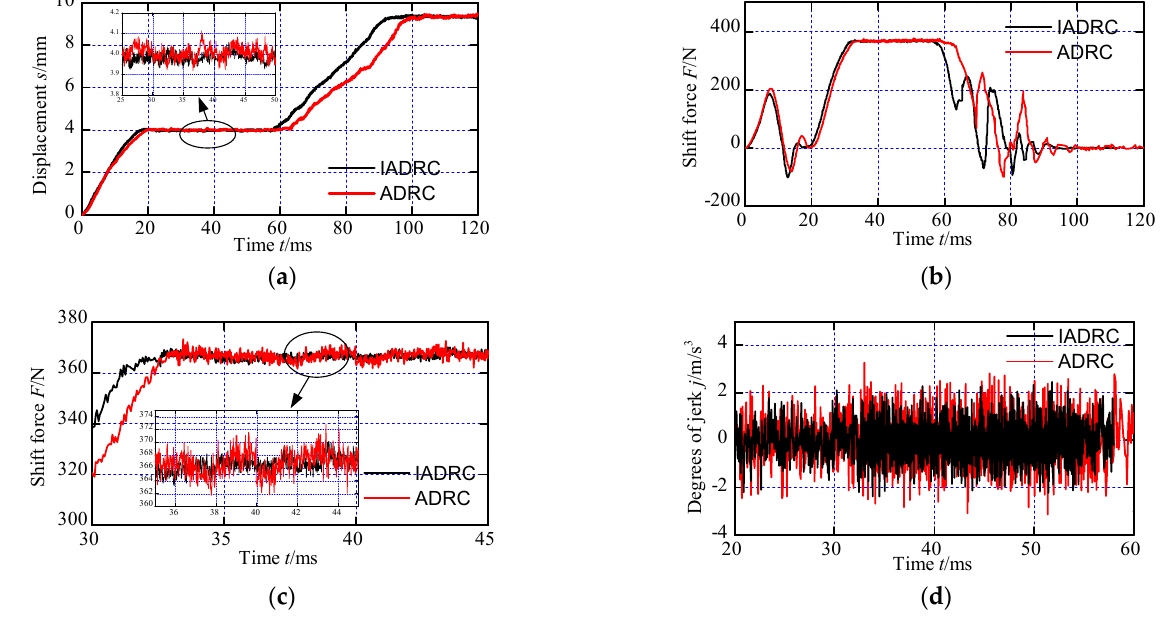
Figure 15. Gearshift experiment results (speed difference 100 r/min): ( a ) Displacement; ( b ) Shift force; ( c ) Amplified shift force during the synchronization process; ( d ) Degree of jerk.